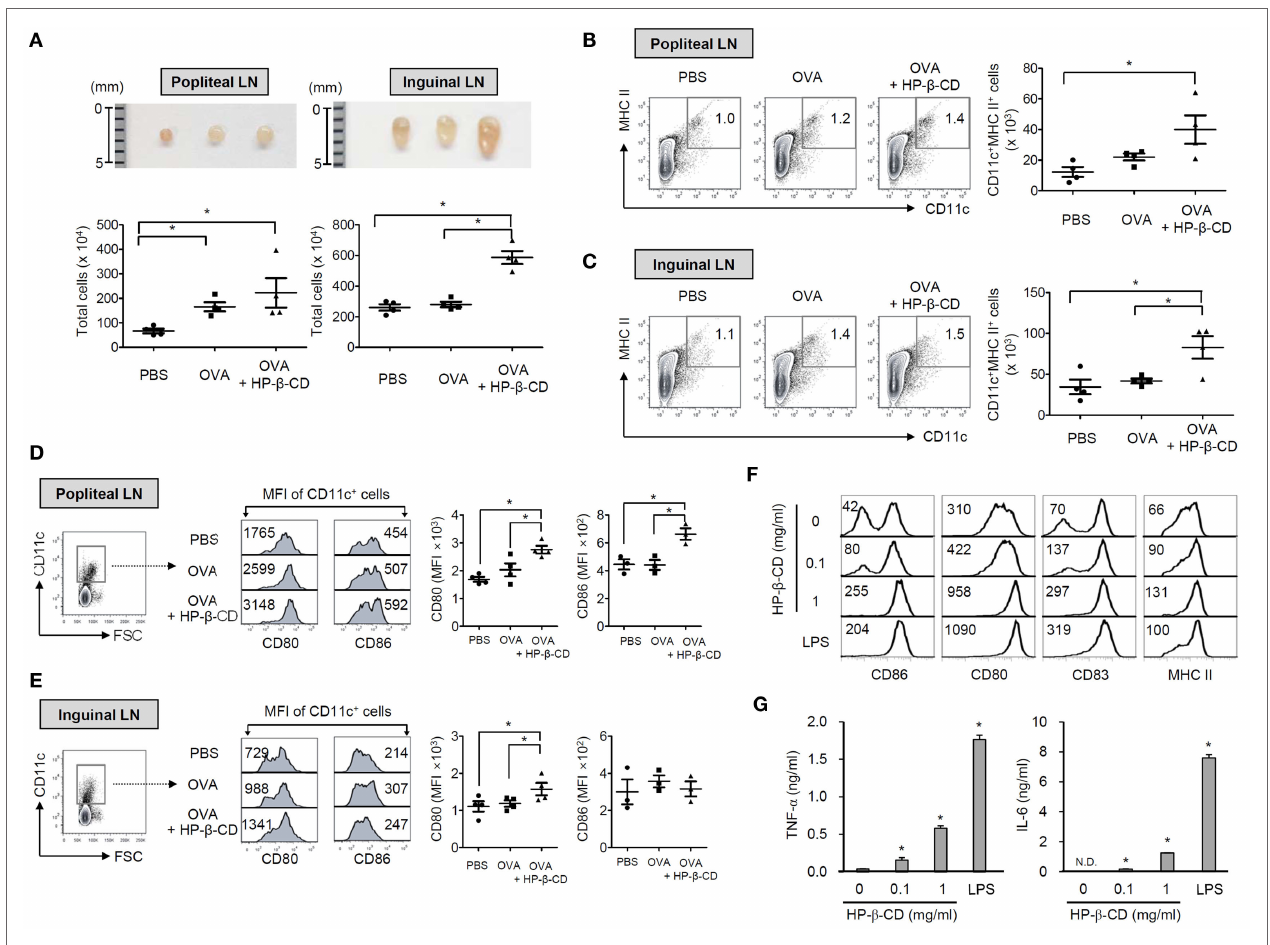
FigUre 5 | hP- β -cD induces Dc maturation and activation in vivo and in vitro mouse models . C57BL/6 mice were immunized with 20 μ g OVA in the presence or absence of 3 mg HP- β -CD through a hind footpad. Twenty-four hours after the immunization, DC populations were analyzed in the draining lymph nodes including popliteal and inguinal lymph nodes. (a) Size of the lymph nodes and the total cell numbers were measured ( n = 4). CD11c + MHC class II + cells in the draining lymph nodes, (B) popliteal and (c) inguinal lymph nodes were analyzed by flow cytometry ( n = 4). Expression of CD80 and CD86 on CD11c + cells was analyzed in the draining lymph nodes, (D) popliteal and (e) inguinal lymph nodes by flow cytometry. Scatter plots on the right side the histograms indicate MFI of DCs for CD80 ( n = 4) and CD86 ( n = 3). (F) BM-DCs (5 × 10 5 cells/ml) were stimulated with HP- β -CD (0.1 or 1 mg/ml) or LPS (100 ng/ml) in the presence of murine GM-CSF for 24 h. The surface expression of various maturation markers, including (F) CD80, CD83, CD86, and MHC class II molecules on the DCs, was analyzed by flow cytometry. (g) The amounts of TNF- α and IL-6 in the culture supernatants of DCs were quantified by ELISA. The number on each histogram indicates percentage or MFI of the DCs. LN, lymph node. N.D., not detected. N.S., not significant. * P < 0.05. The result shown is a representative of four similar